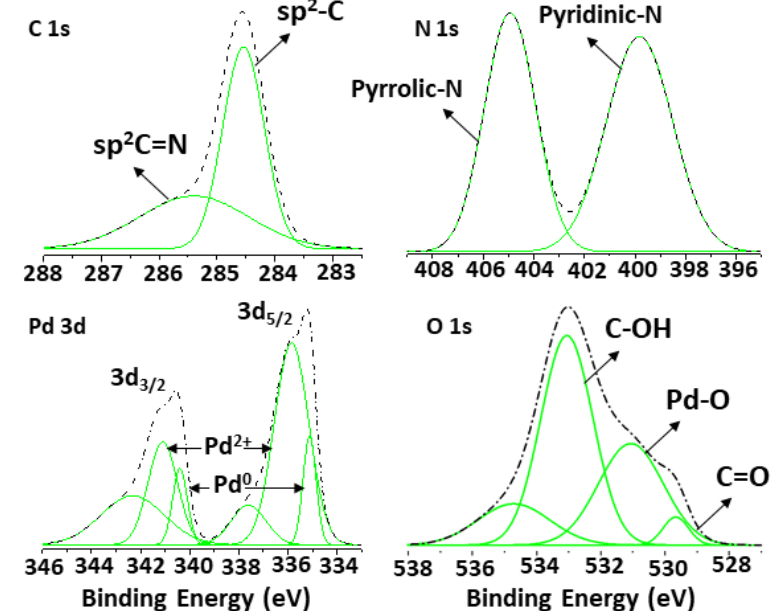
Figure 8. High-resolution XPS elemental scan of NDG@Pd composites.